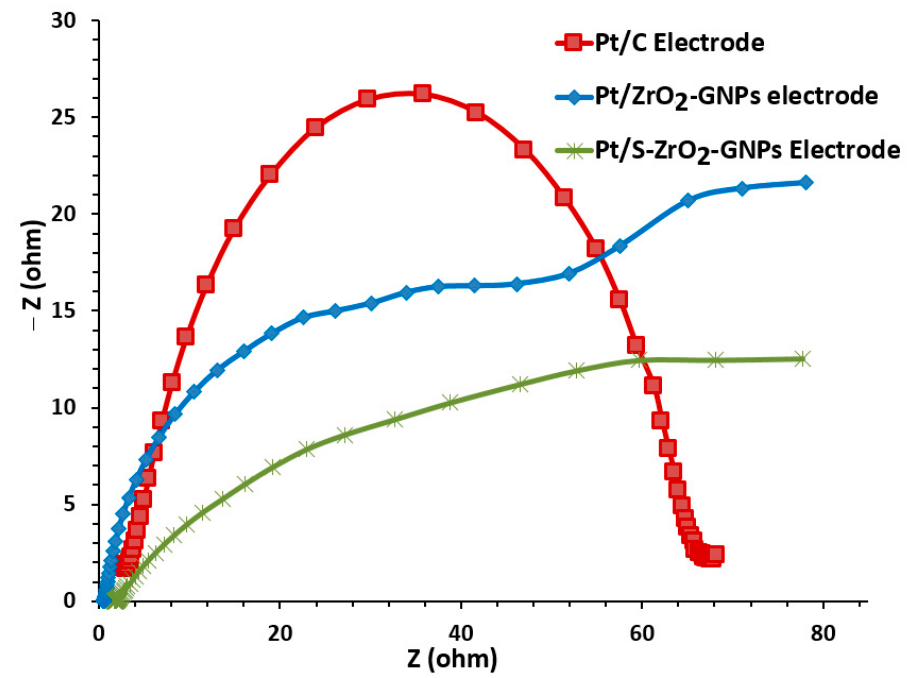
Figure 10. EIS diagram in Nyquist form of Pt/S-ZrO 2 -GNPs, Pt/ZrO 2 -GNPs, and Pt /C electrodes in